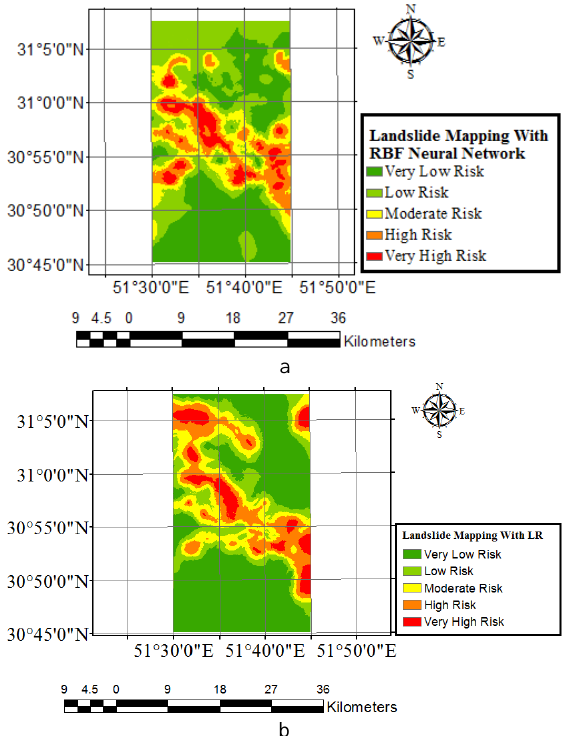
Figure 7. a Landslide hazard map with RBF Neural Network, b Landslide hazard map with LR